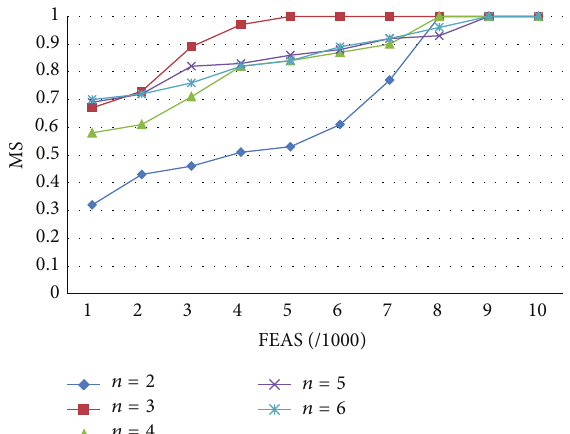
Figure 5: Comparison of number of competition items of tourna- ment